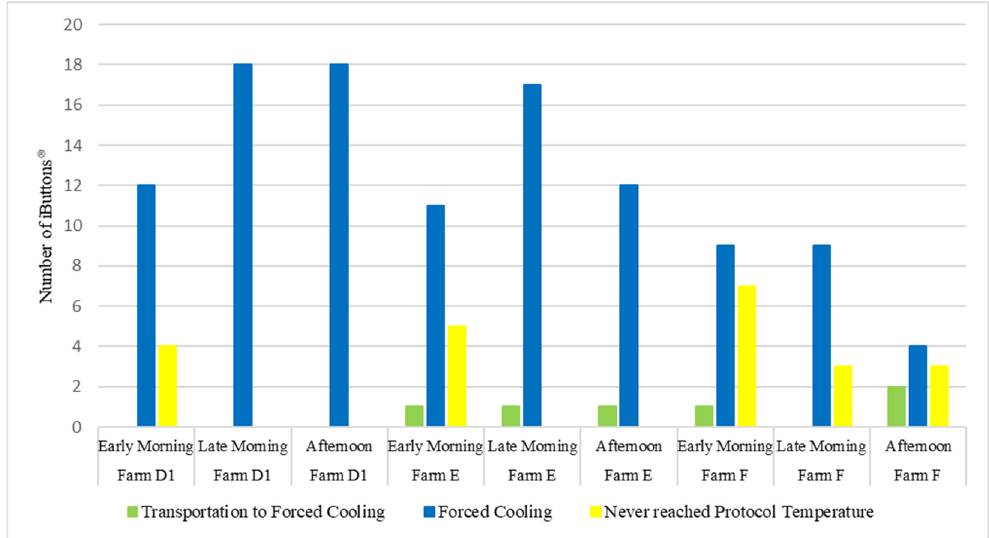
Figure 13. Stage during which PT = 0 °C was reached on Gauteng farms. Source: [13].